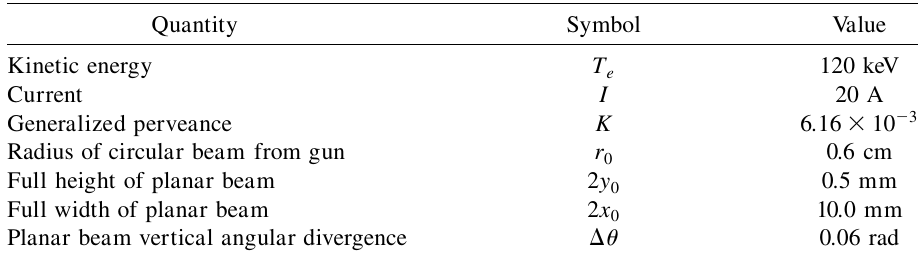
Parameters of the Los Alamos TWT